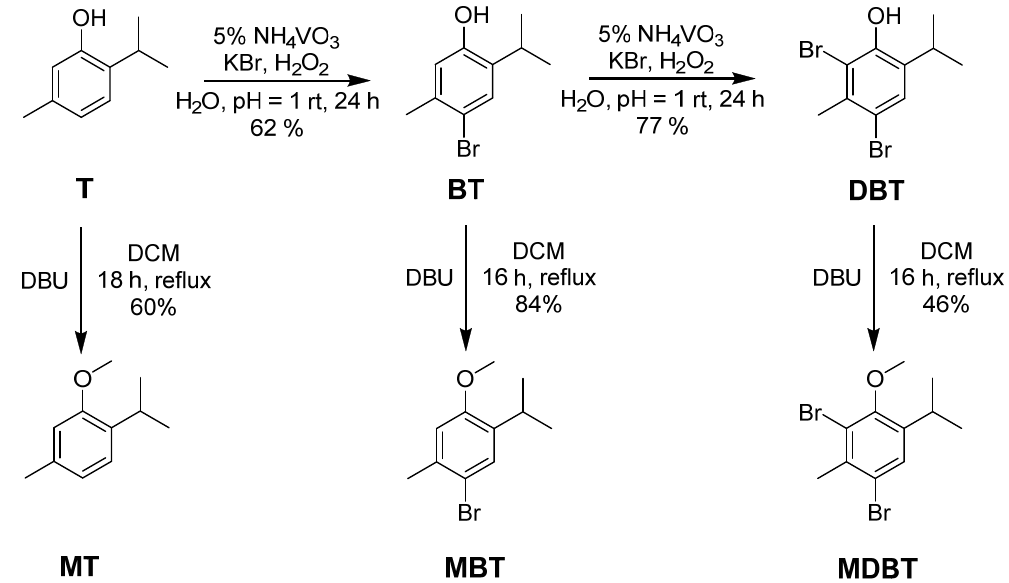
Scheme 1. Overview of synthetic efforts leading to the thymol derivatives used in this